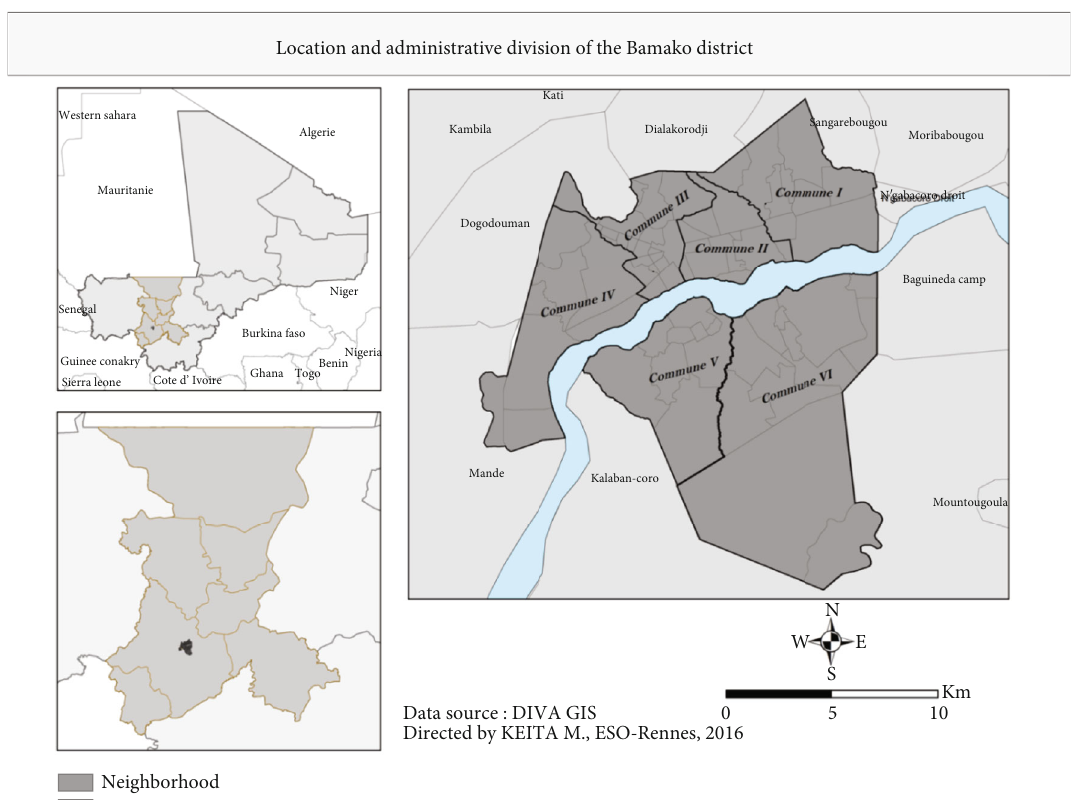
Figure 1: Location of the city of Bamako and its administrative division. Source: [11].